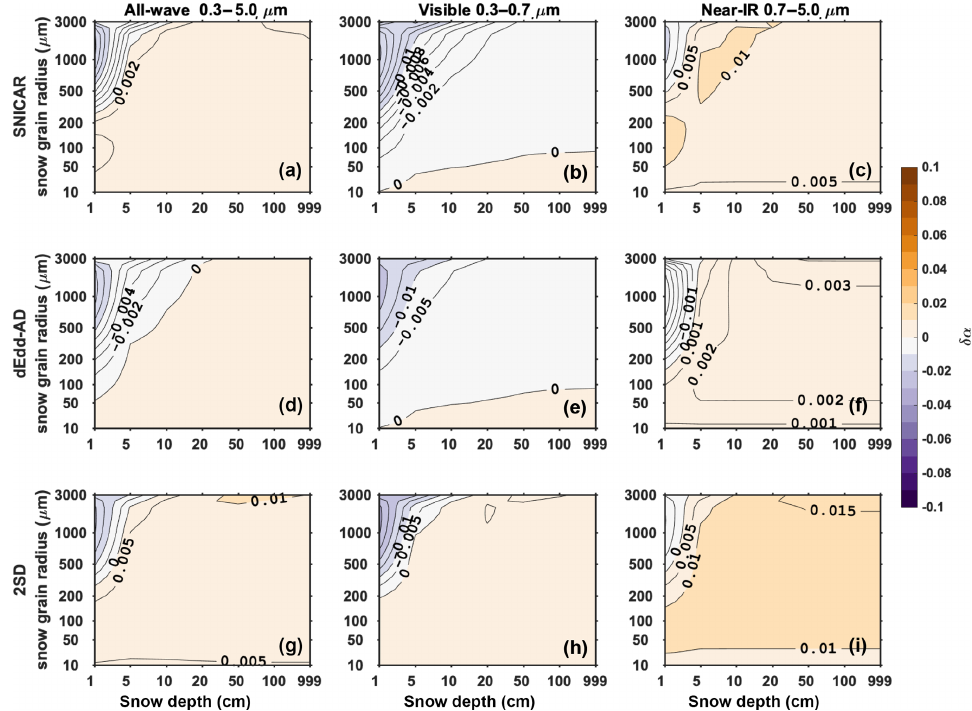
Figure 5. The difference in direct snow albedo ( δα = α 2 − α 16 ) computed using two-stream models ( α 2 ) and using the 16-stream DISORT model ( α 16 ), for various snow depths and snow grain radii, with a solar zenith angle of 60 ◦ .